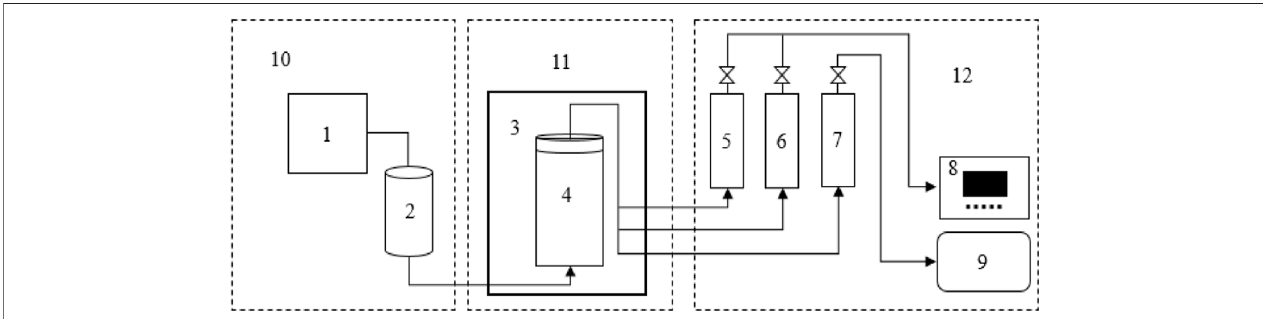
FIGURE1| Schematicrepresentationoftheexperimentalapparatus.1 – 260Ddoublecylinderconstantpressureconstantspeedpump,2-pistoncontainer,3-DC- 0530 water bath, 4- cylindrical Hastelloy reactor, 5- pressure transducer, 6-PT100 temperature transducer, 7- gas fl owmeter, 8- monitor, 9- gas collecting bag, 10- liquid injection system, 11- low-temperature reaction system, 12- data acquisition system.